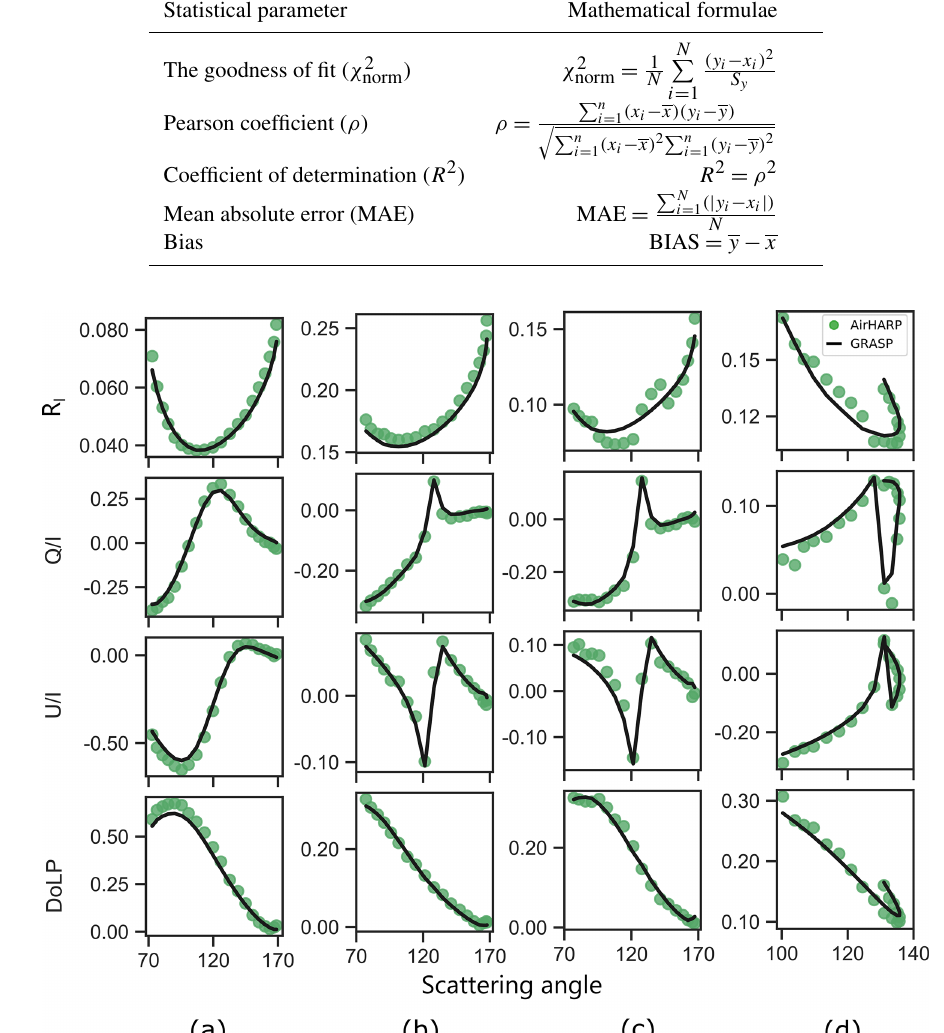
Table 5. Definition of statistical parameters used in this study to find the correlation between measurement and models.